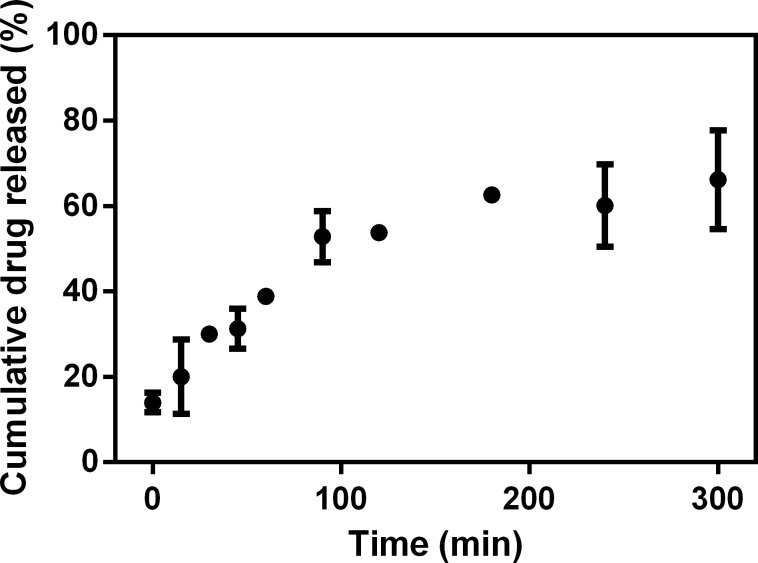
Cumulative release profile of 15d-PGJ2–loaded SLN in vitro in aqueous solution at 25°C (n = 3).